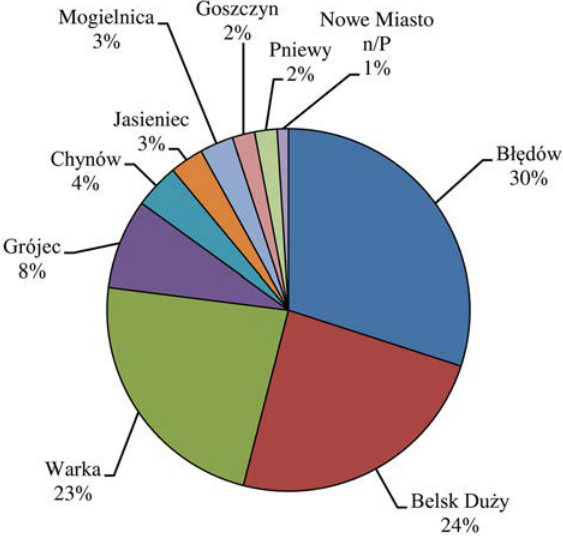
Fig. 9. Share of individual communes in fruit production in Grójec